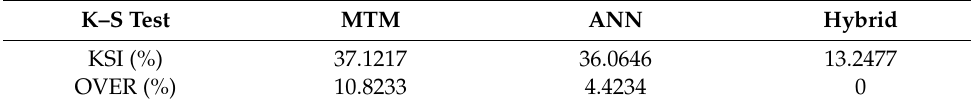
Figure 12. Estimation results of the MTM, ANN, and hybrid models: ( a ) CDF and ( b ) K–S statistic (Dn). Table 4. Estimated KSI and OVER of results of the MTM, ANN, and hybrid models.